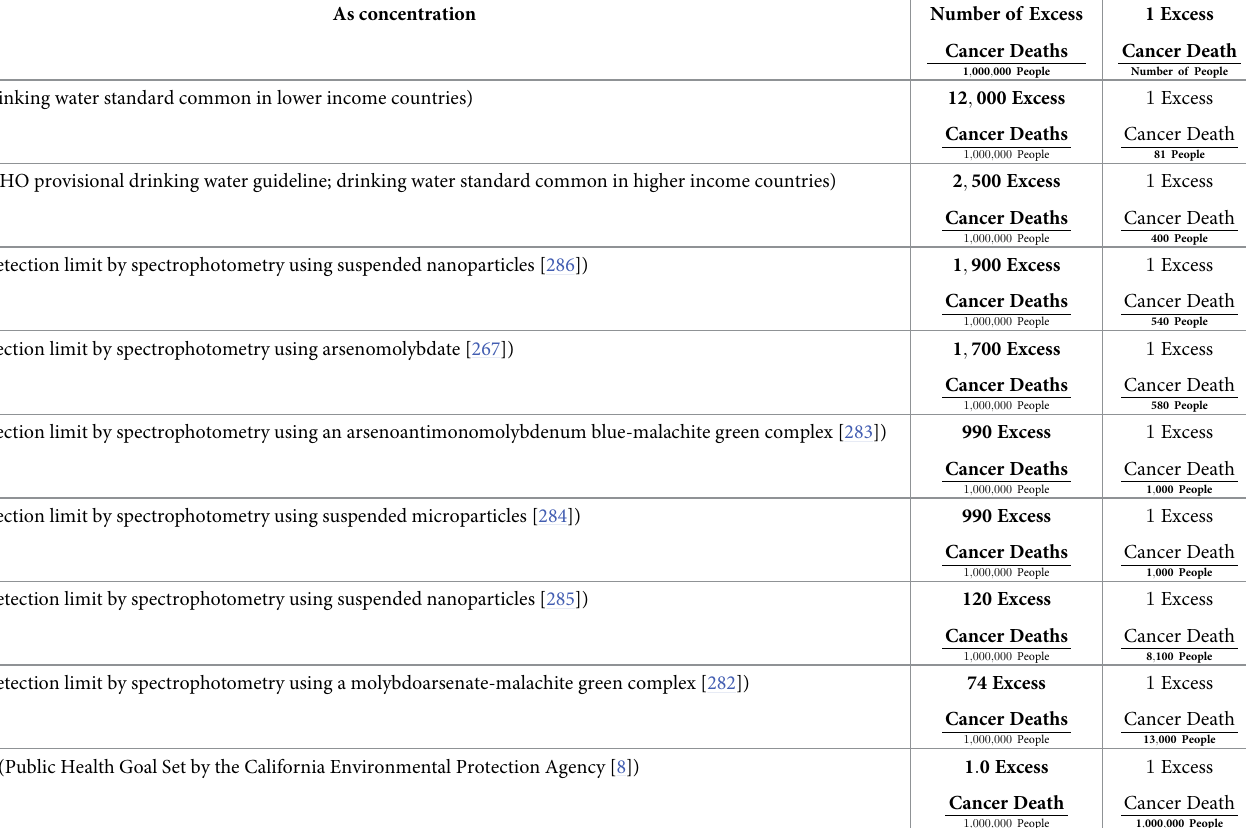
Table 2. Common drinking water standards, guidelines, and public health goals for total arsenic (As) in micrograms per liter ( μ g/L), the detection limits for total As in μ g/L by spectrophotometry, and the estimated cancer risks at these concentrations (Eqs 1, 2, 3, 4, 5 and 6). These cancer risks are in bold font and rounded to 2